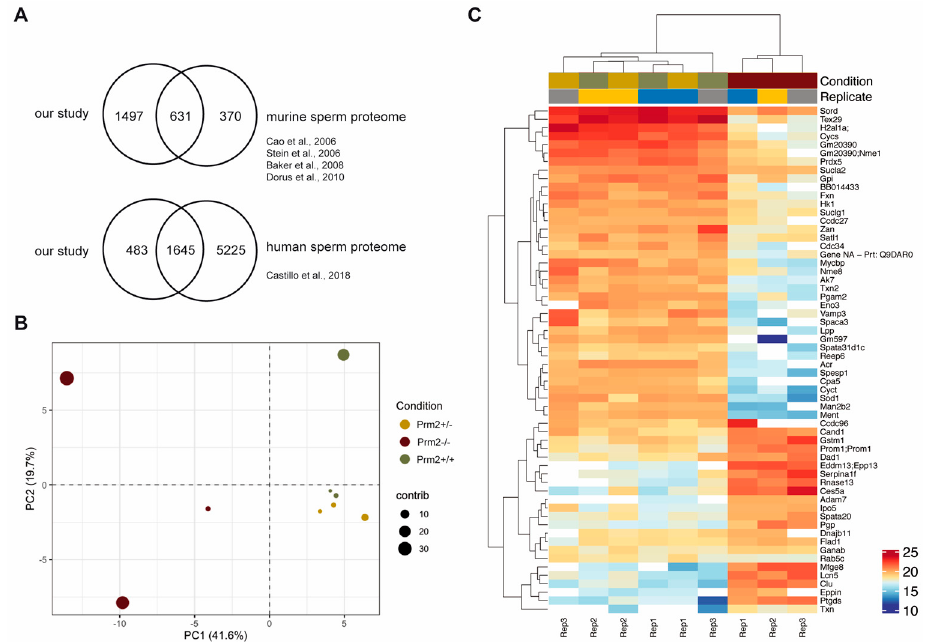
Figure 1. The sperm proteome of Prm2 -deficient mice. ( A ) Venn diagrams showing the overlap of the generated dataset with published datasets of murine and human sperm. ( B ) Principal component analysis (PCA). MS comprised three biological replicates per genotype. Contribution of each dataset to the PCA is reflected by the dot size. ( C ) Heatmap visualization of the top 50 most significantly deregulated proteins (|log 2 FC| > 1; FDR < 0.05) between Prm2 +/+ , Prm2 +/ − and Prm2 − / − samples. No proteins were found to be significantly up- or downregulated (Figure 2A). However, in the knockout condition, 24 proteins were found to be significantly deregulated compared to wildtype (17 down- and 8 upregulated) (Figure 2A). A highly similar set of deregulated proteins was observed by pairwise comparison of knockout and heterozygous samples (Figure 2A). Many of the differentially expressed proteins, including SORD, SOD1, PRDX5 and ACR have a well-known function for male fertility and sperm motility [61–64]. Thus, deregulated proteins correlate with the observed defects. To investigate whether deregulations can be attributed to specific biological processes, reactome pathway analysis was performed, showing a significant enrichment of downregulated proteins in processes of energy metabolism and the detoxification of ROS (Figure 2B). Further, STRING analysis suggests a strong interaction among the downregulated proteins (Figure 2C). Taken together, MS data imply that loss of PRM2 triggers a molecular cascade that initiates described secondary sperm defects, which ultimately result in male infertility.